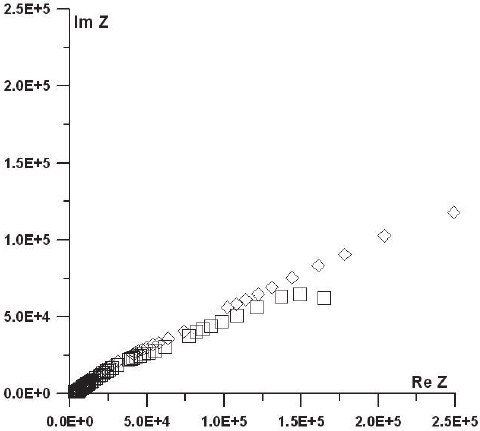
Fig. 9. The complex resistivity plane representation of the sample for relative saturations 96% ( ), 100% ( ),